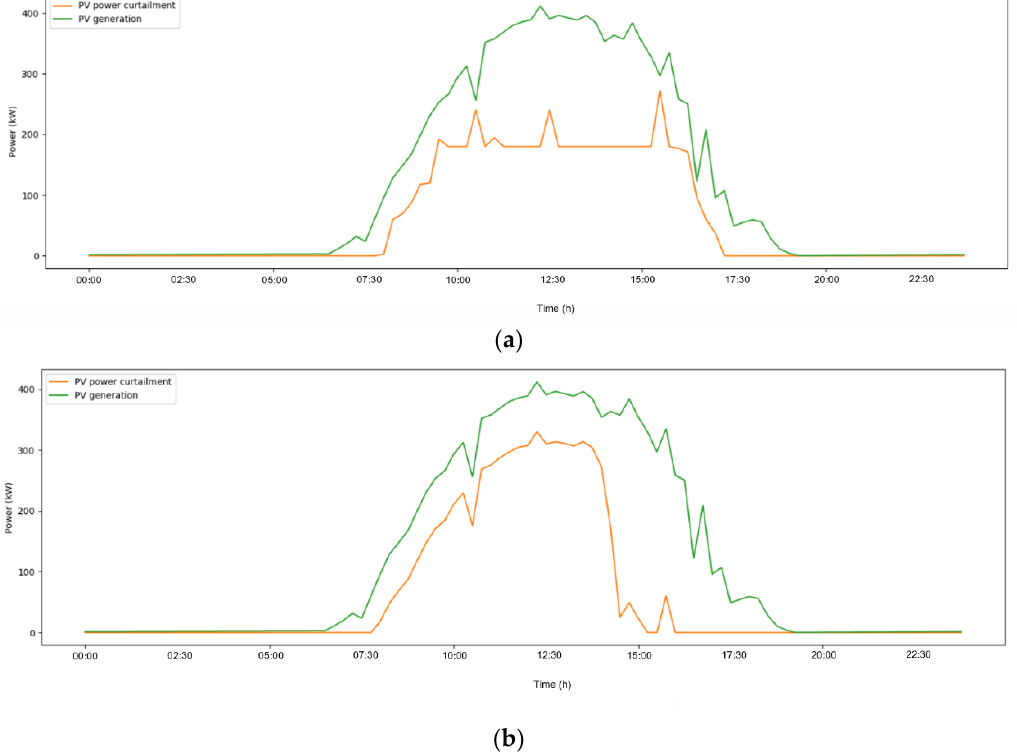
Figure 6. Comparison of PV curtailment scheduling with proposed curtailment gradation cost result ( a ) and conventional linear curtailment cost result ( b ). Table 3. Optimal PV curtailment scheduling results during generation time.